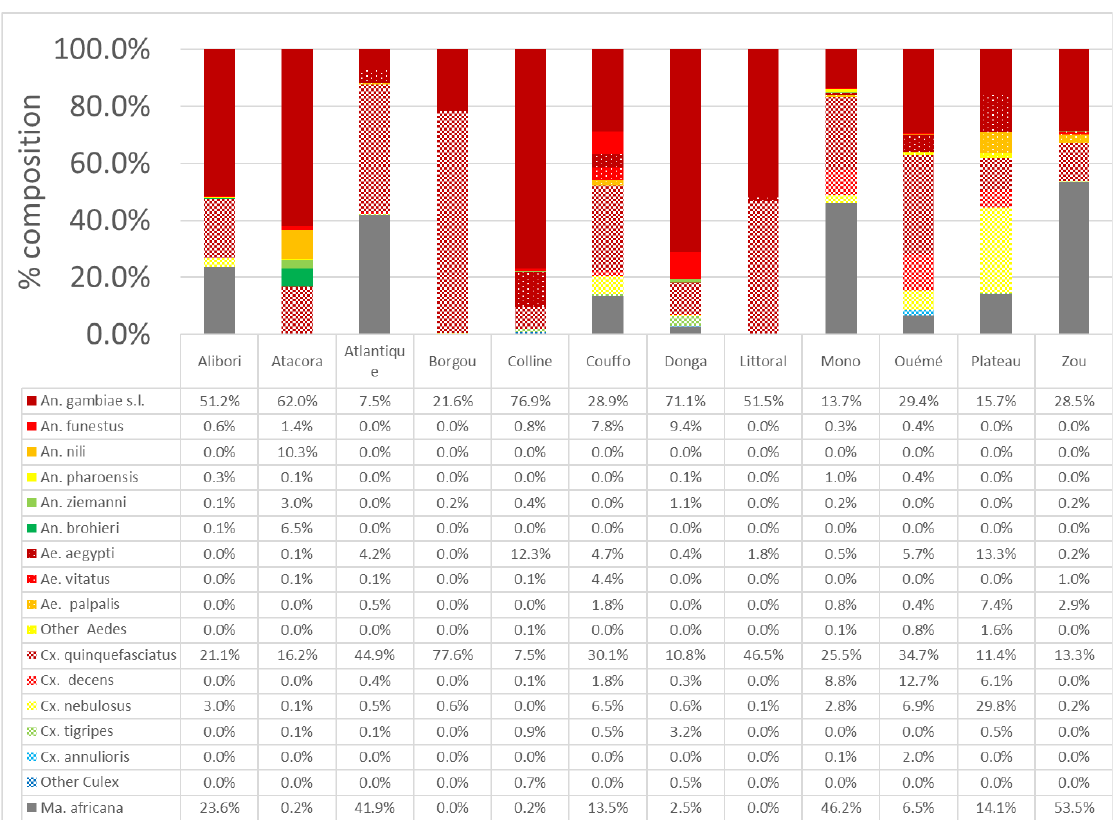
Figure 2. Culicidae diversity and abundance in the 12 departments of Benin.